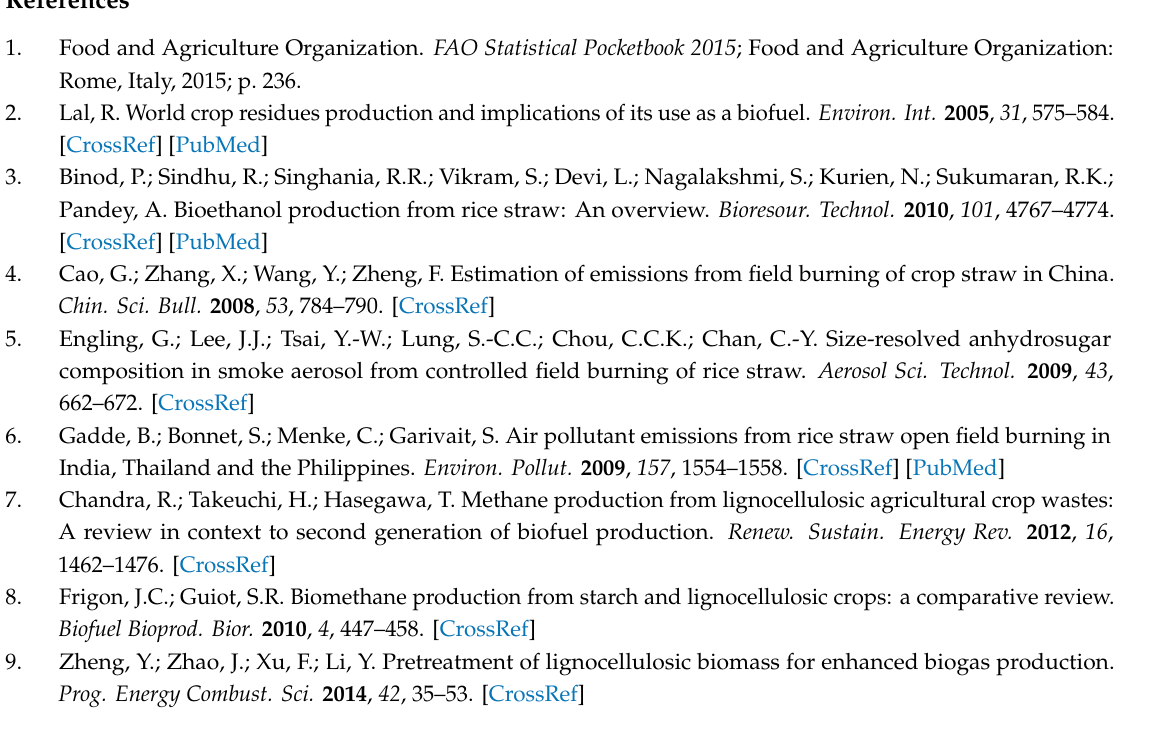
Figure S1. Temperature profile of steam explosion experiments that lead to di ff erent severity parameters S 0 ;